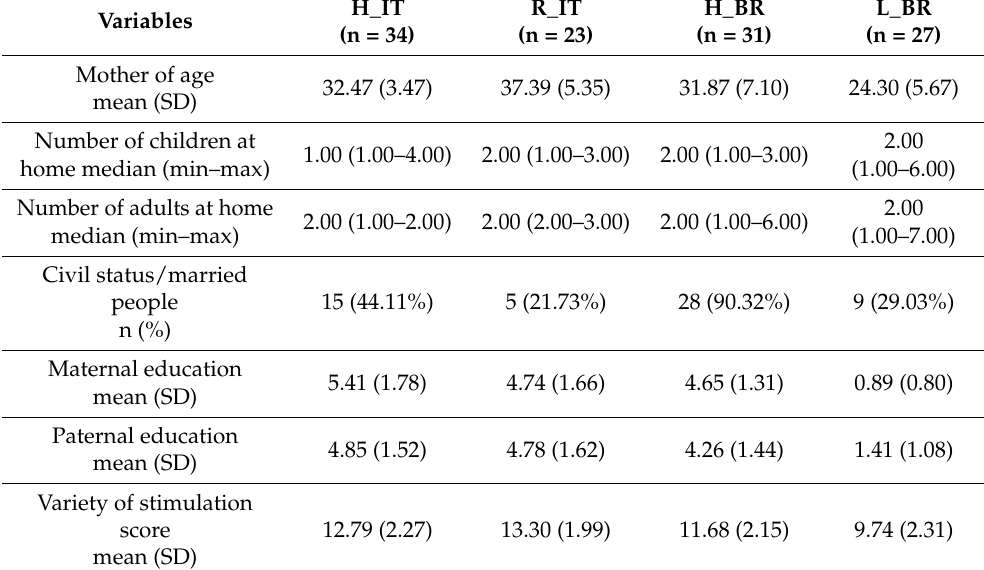
Table 1. Characteristics of